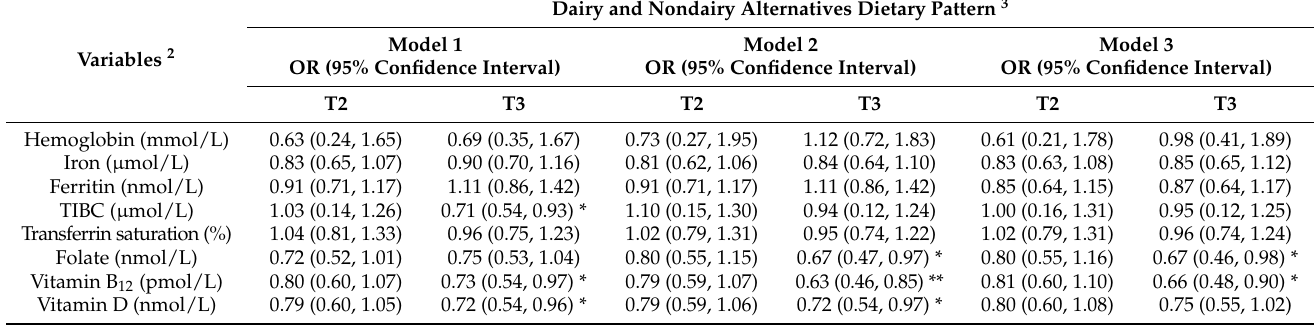
Table 8. Odds ratios (ORs) of low-anemia-related biochemical variables in serum across the tertiles of dairy and nondairy alternatives dietary pattern assessed by binomial logistic regression analysis 1 .